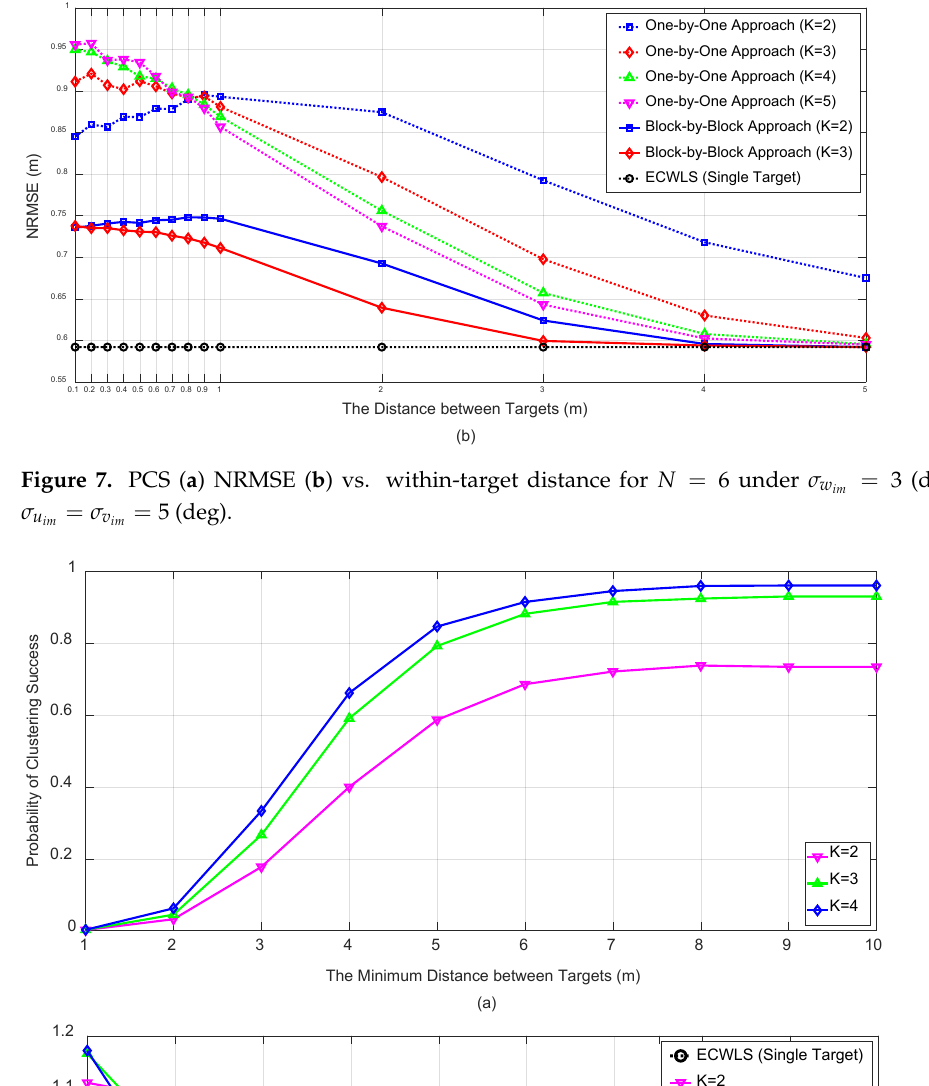
Figure 8. PCS ( a ) and NRMSE ( b ) vs. target minimum distance for M = 4 and N = 6 under = 3 (dB) and σ u = σ v = 5 (deg). σ w im im im Figure 9 shows the NRMSE performance of the proposed algorithm for the number of targets M = 2, 3 and initial anchor nodes K = 2, 3 for the one-by-one approach, and initial anchor nodes K = 2 for block-by-block approach under various RSS noise ( σ w = σ = 5 (deg) with N = 6 from 1 to 6 dB. The angle noise level was set to σ u v im im